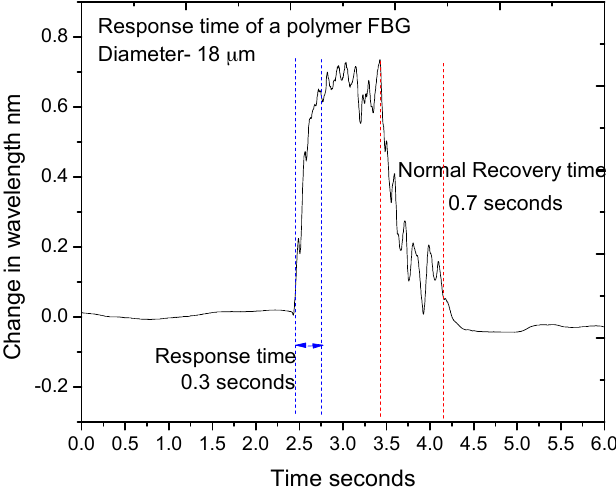
Figure 12. Response and recovery time of the 18 µm PFBG.